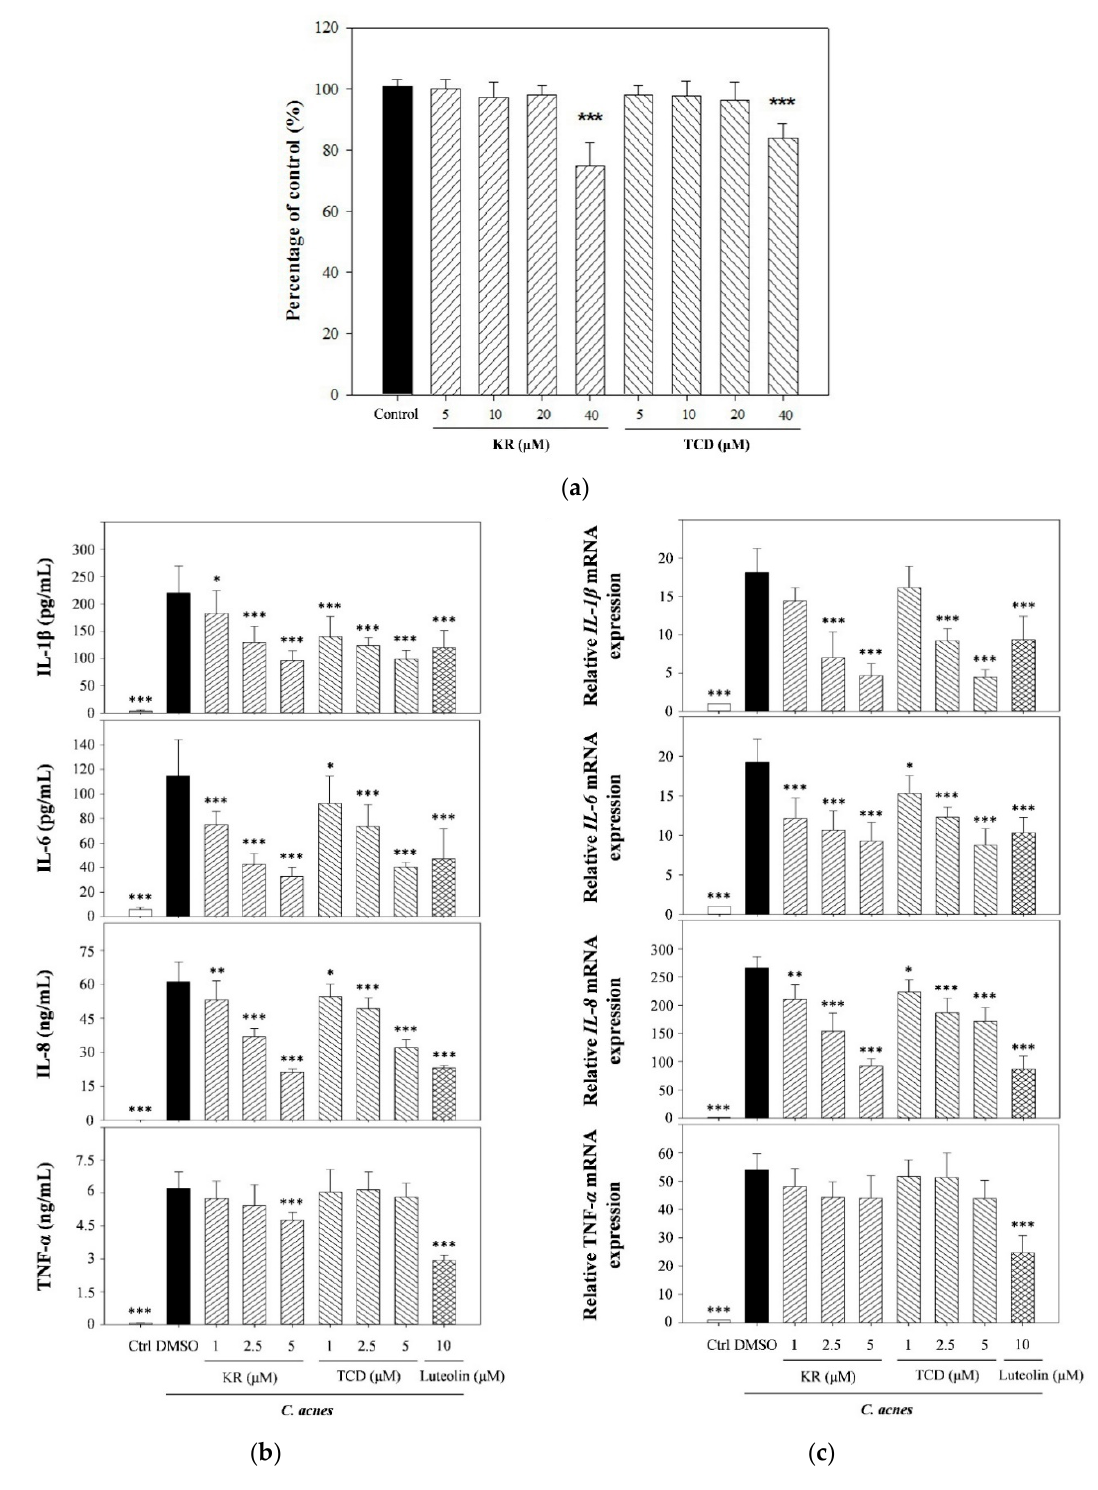
Figure 2. Effects of KR and TCD on cell viability of THP-1 cells ( a ) and C. acnes -induced production ( b ) and gene expression ( c ) of pro-inflammatory cytokine in human monocytic THP-1 cells. THP-1 cells were incubated with DMSO as the negative control, or co-cultured with C. acnes (M.O.I. = 75) and different concentrations (1, 2.5 or 5 μ M) of KR or TCD for 24 h (production) ( a ) or 16 h (gene expression) ( b ). The cell-free culture supernatants were subsequently collected and analyzed for their content of IL-1 β , IL-6, IL-8, and TNF- α . Each value represents the mean ± SD. Values with different symbols are significantly different from the C. acnes control ( C. acnes alone) at p < 0.05 (*), p < 0.01 (**), and p < 0.001 (***).